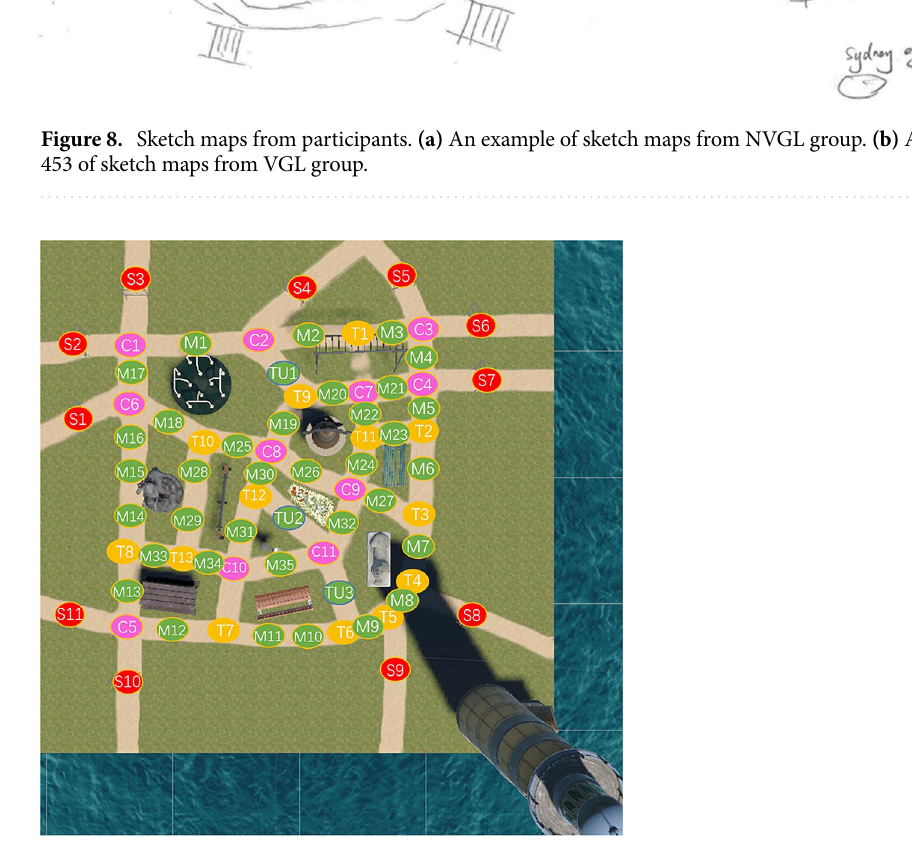
Figure 9. Checkpoint map. The red checkpoints define the starting points; the green checkpoints are those in the middle of one path; the purple checkpoints appear at crossroads; and the yellow checkpoints represent a T intersection. The background map is a top view of the “Sydney Park”